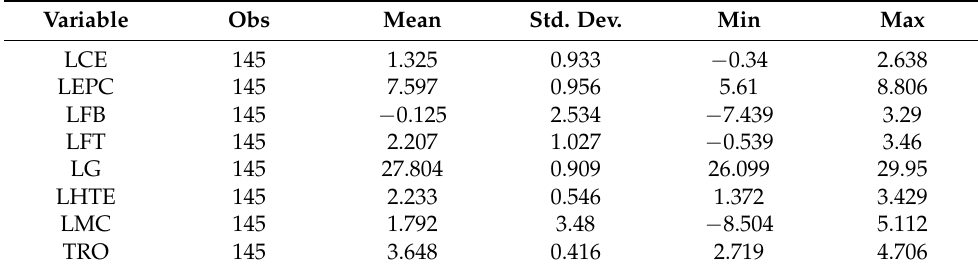
Table 1. Descriptive